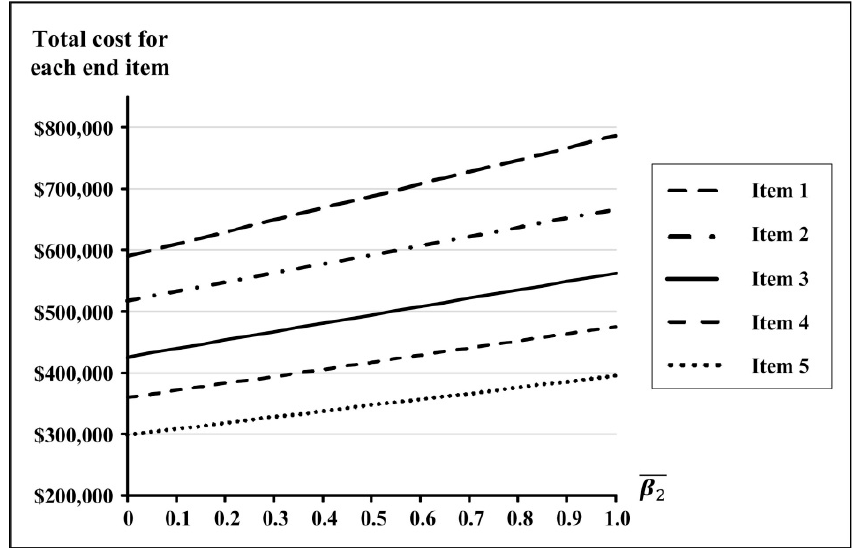
(cid:3364)(cid:3364)(cid:3364) on each item’s total cost. (cid:2870)